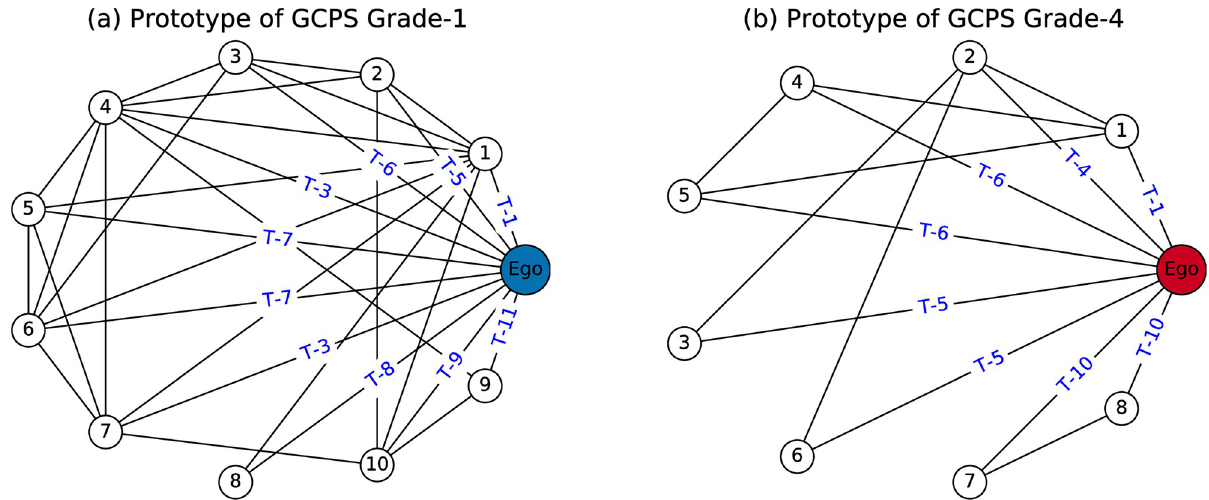
Fig 6. Social network prototypes of patients with GCPS grade-1 and patients with GCPS grade-4. (a). In the prototype network of patients with pain grade-1, contacts are tightly connected to each other with the appearance of T-5 friend and T-9 colleague; (b) In the prototype network of patients with pain grade-4, contacts are loosely connected with limited links incident to T-5 friend and T-10 healthcare workers.